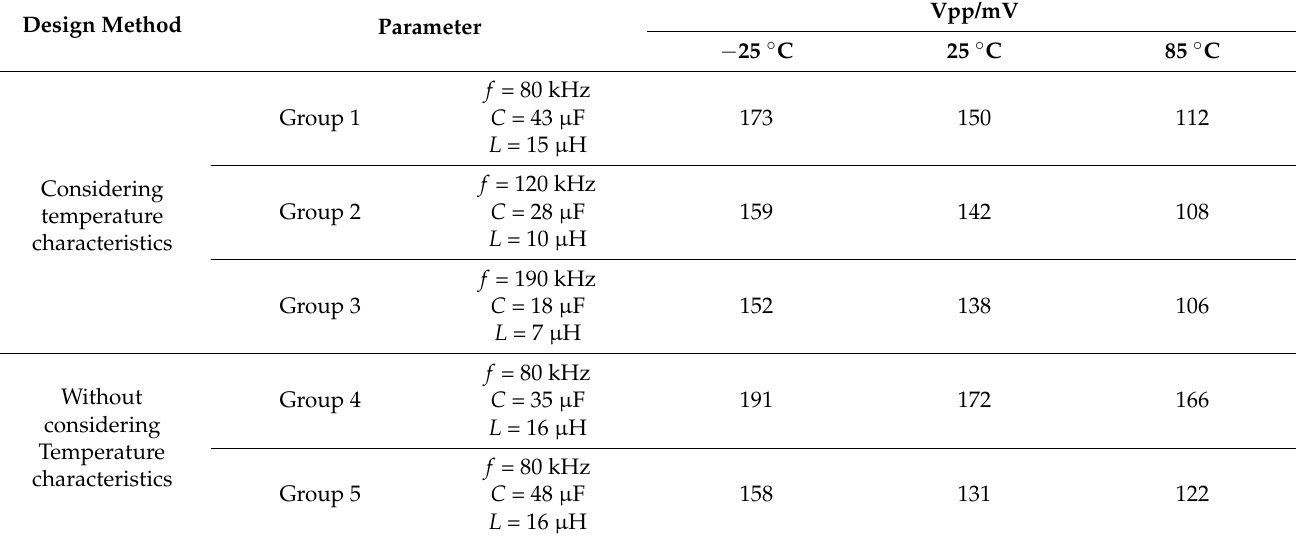
Table 2. Output ripple voltage of the prototype.